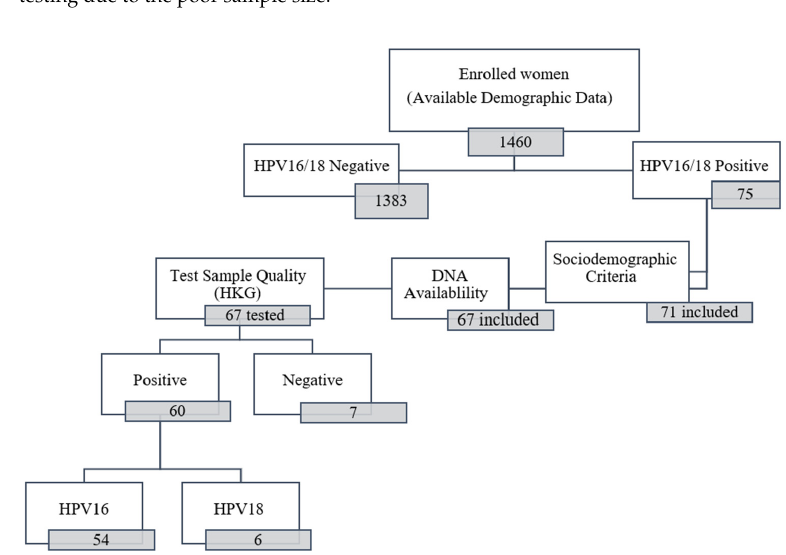
Figure 1. Schematic of the final study sample population after application of inclusion and exclusion criteria. Numerals in boxes represent the number of specimens. HKG indicates the housekeeping gene assay.